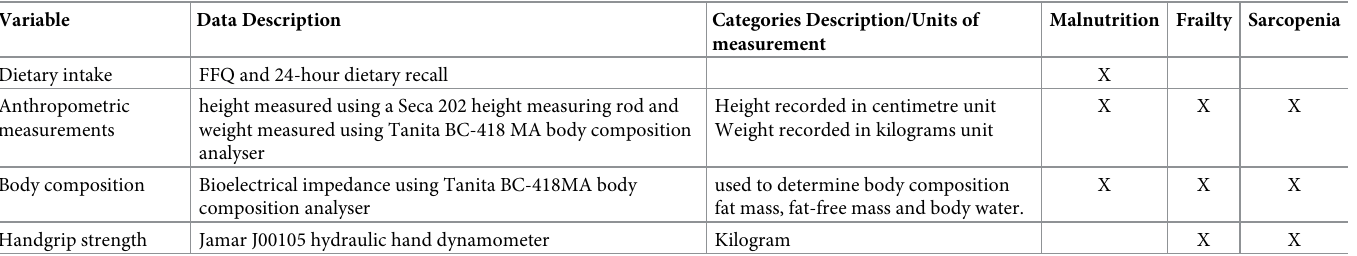
Table 2. Variable mapped to malnutrition, frailty and sarcopenia.